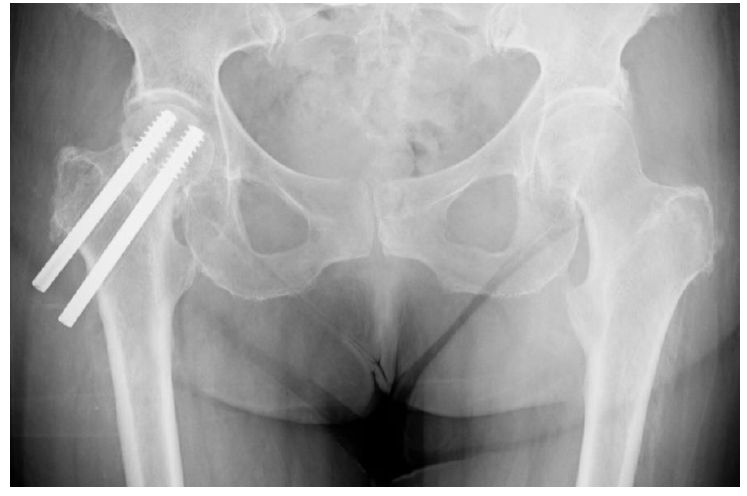
Figure 4. Avascular necrosis development after CSFN implantation in anteroposterior view.